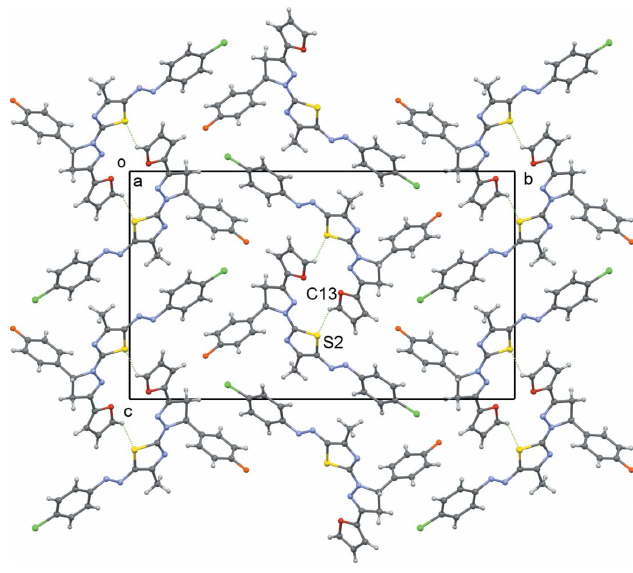
Figure 2 A view of the crystal structure down [100] showing intermolecular short contacts as dotted lines.